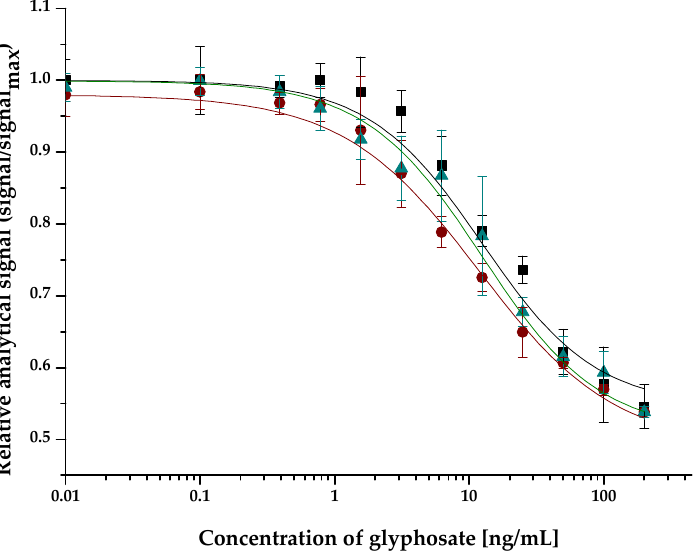
Figure 3. Calibration curve of the competitive enzyme-linked fluorescent immunoassay obtained in assay buffer (black), and in leaf (green) and root (brown) extracts of the plant tissue samples at a concentration range of 0 – 400 ng/mL glyphosate.